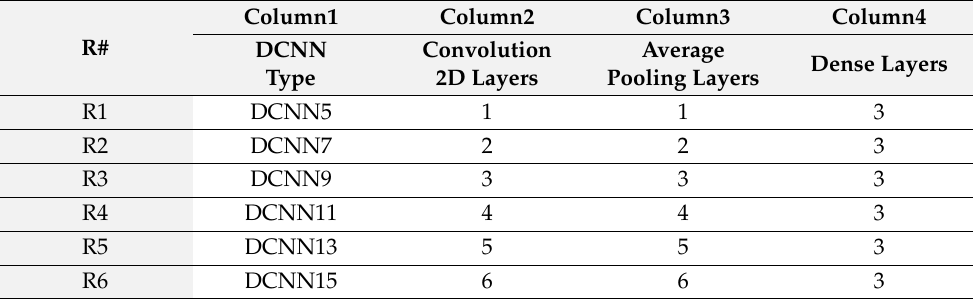
Table A1. Six types of DCNN models consisting of a different combination of convolution, average pooling, and dense layers. The total number of layers is shown as the number “X” at the end of DCNN in column 1.